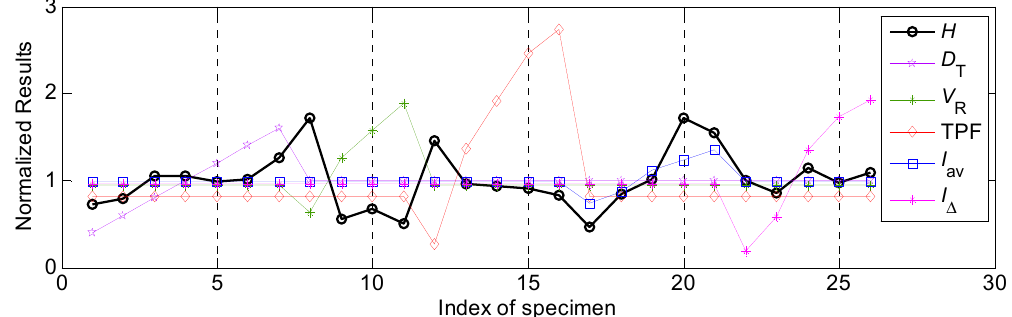
Figure 8. The normalized results of various process parameters and penetration.